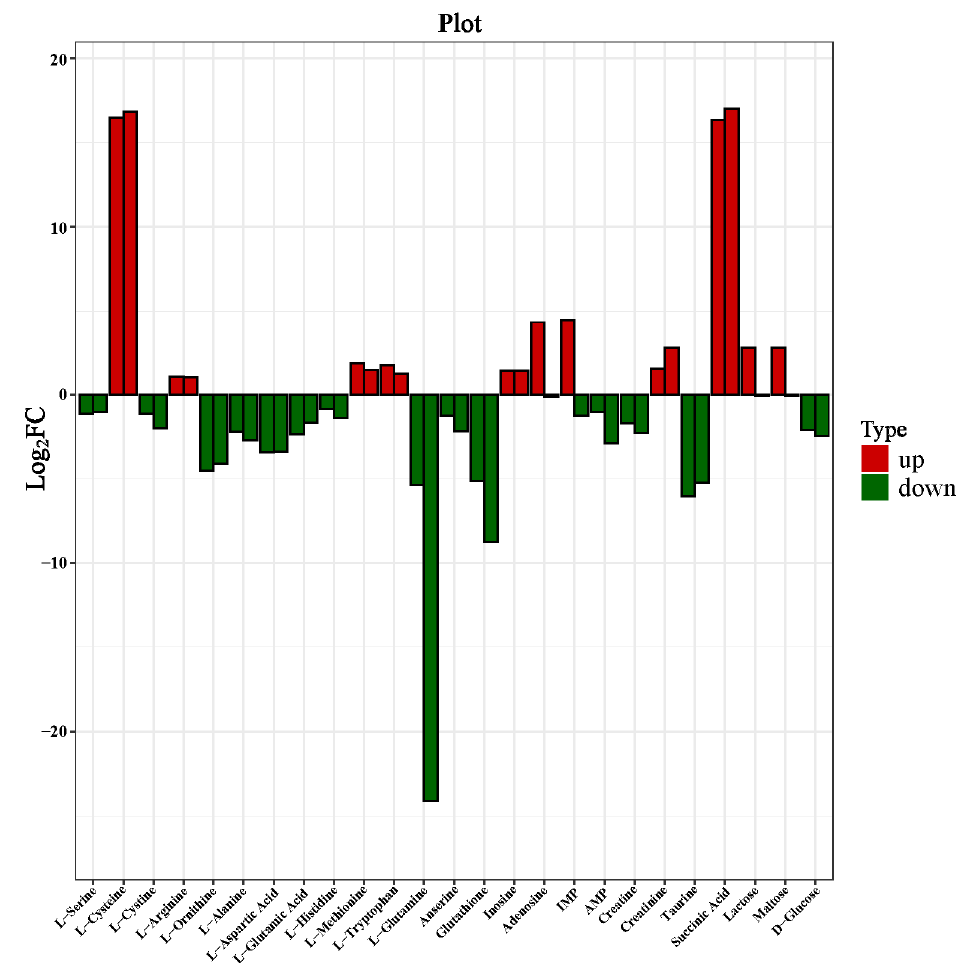
Figure 4. The relative content of different metabolites of dry-cured beef at the processing stage of FG (fermented group) and RG (ripened group), with CG (control group) used as a